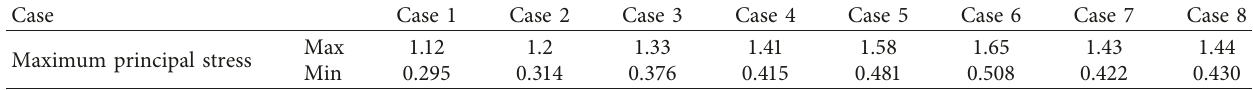
Table 8: Maximum principal stress of the inverted arch in different cases (MPa).